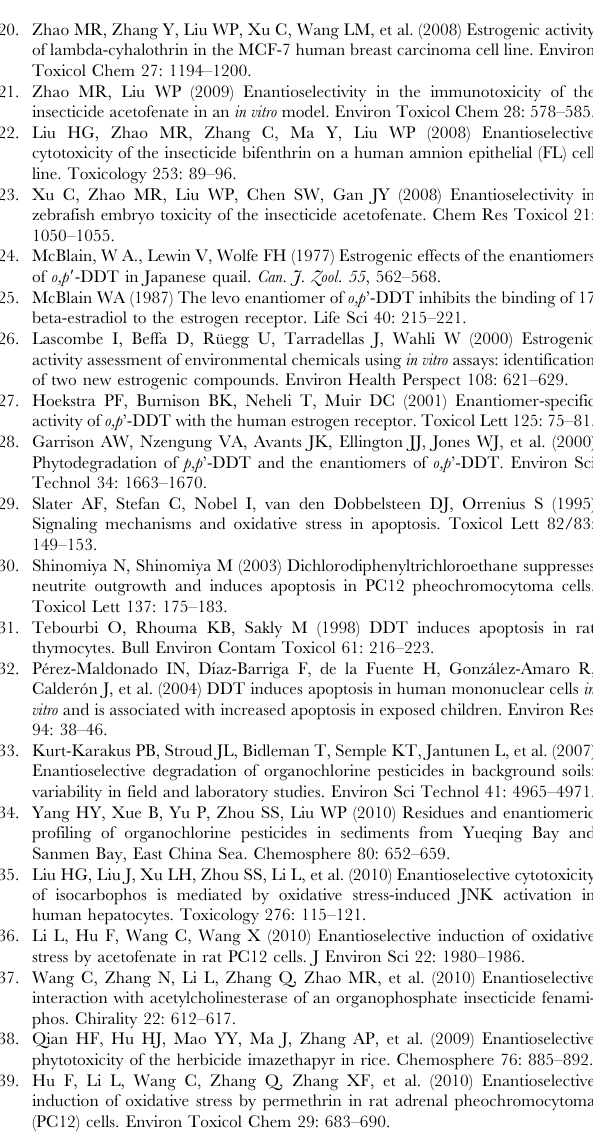
Table S9 The relative fold change of CARD family (DOCX) Table S10 The relative fold change of CIDE domain family (DOCX) Table S11 The relative fold change of death domain and receptor domain family (DOCX) Supporting Information S1 Additional experimental